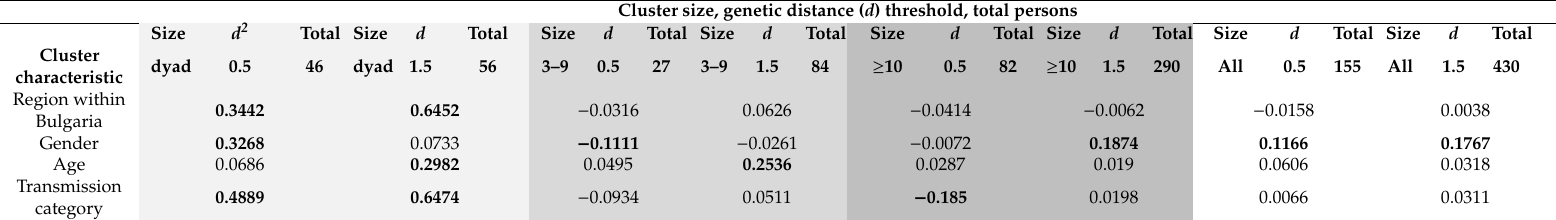
Table 4. Assortative mixing of subtype B clusters in Bulgaria by region, gender, age, and transmission category 1 .